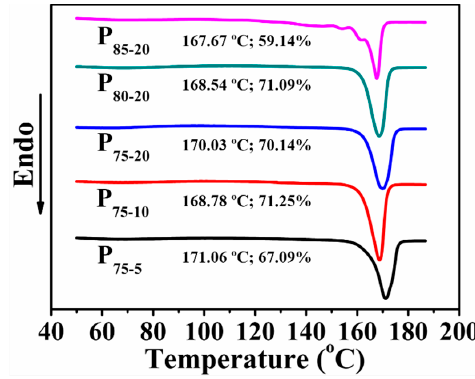
Figure 5. DSC melting thermograms of scaffolds for different compositions.